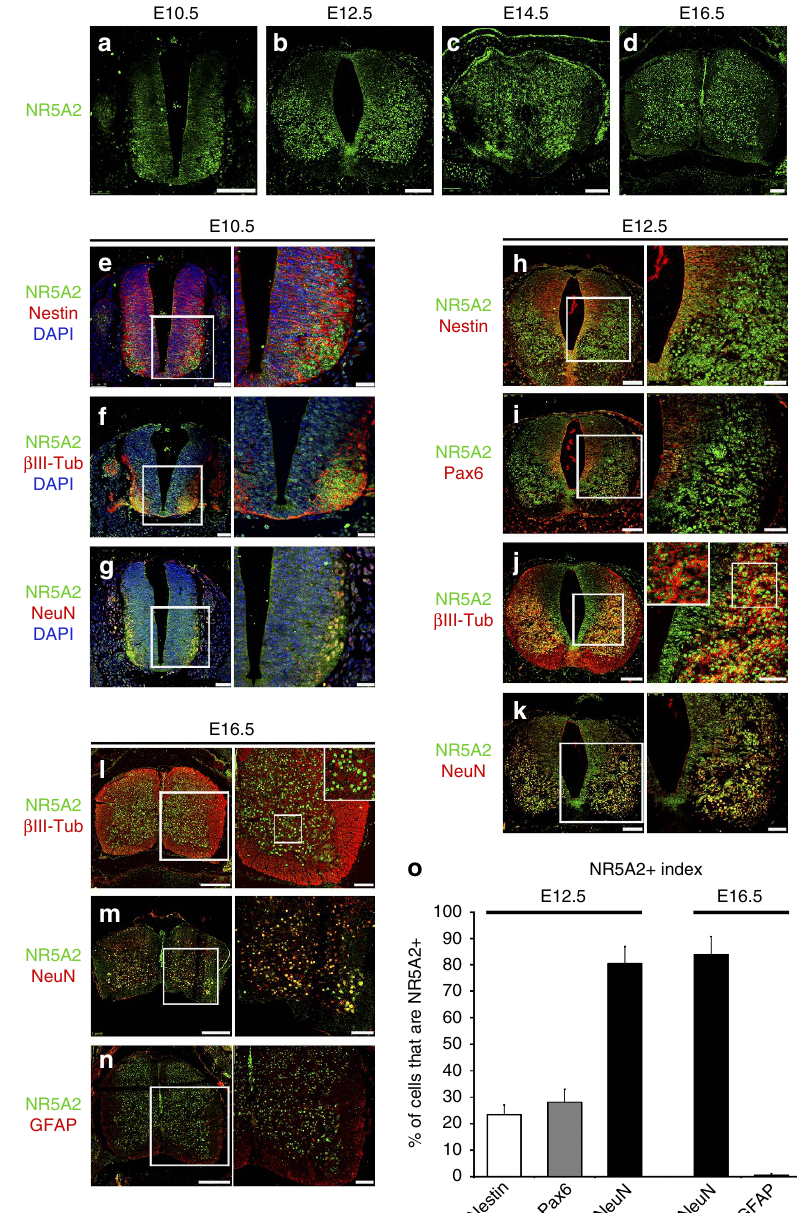
Figure 1 | NR5A2 expression pattern is correlated with neuronal lineage during spinal cord development. ( a – d ) Immunostainings of NR5A2 (green) on transverse paraffin sections from E10.5 ( a ), E12.5 ( b ), E14.5 ( c ) or E16.5 ( d ) mouse spinal cord. ( e – n ) Double immunostainings of NR5A2 (green) with Nestin ( e , h ), Pax6 ( i ), b III-Tubulin ( f , j , l ), NeuN ( g , k , m ) or GFAP ( n ) (all red) at E10.5 ( e – g ), E12.5 ( h – k ) or E16.5 ( l – n ) mouse spinal cord, as indicated. Control immunofluorescences without primary antibody showed no staining. Inlets in the right panels of j and l represent larger magnifications of the areas included into the square shapes of the corresponding images. ( o ) Quantification of the cell populations that express NR5A2 (% of marker þ ; NR5A2 þ /total marker þ ). Values represent the mean ± s.d. of four animals ( n ¼ 4). Scale bars, ( a – d ), 100 m m; ( e – g ), 50 m m, 25 m m; ( h – k ), 100 m m, 50 m m; ( l – n ), 250 m m, 75 m